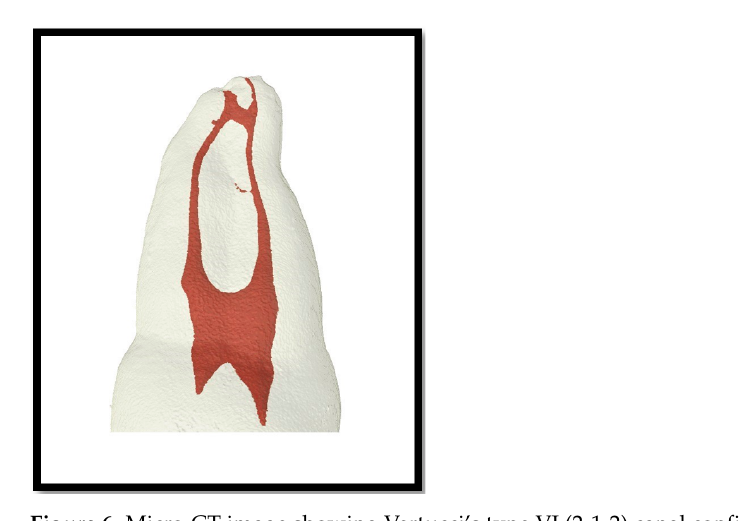
Figure 5. Micro-CT image showing Vertucci’s type V (1-2) canal configuration.